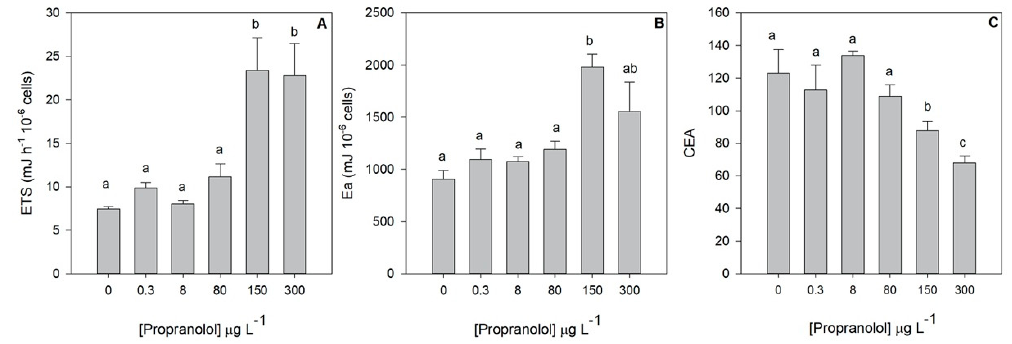
Figure 5. Contribution of the light and dark reactions to the primary photochemistry ( A ) and redox equilibrium constant between photosystem I and II ( B ) in Phaeodactylum tricornutum cultures exposed to different propranolol concentrations (average ± standard error, n = 3, letters denote differences at p < 0.05).